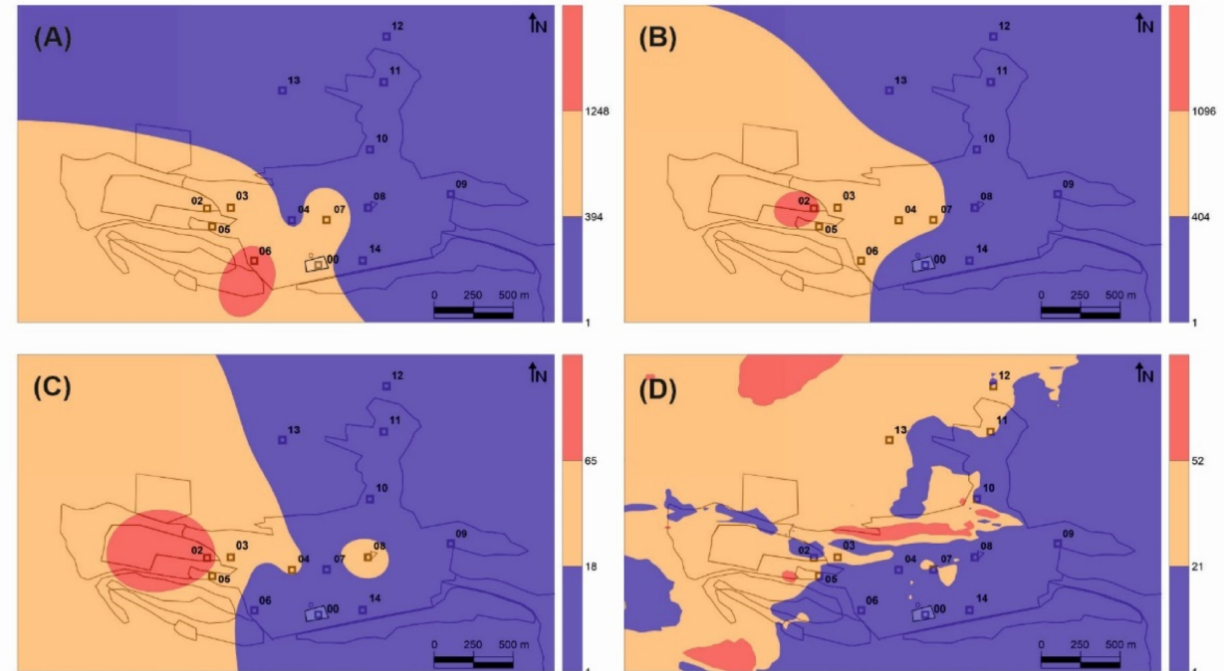
Figure 2. Distribution maps of THg content in bark ( A ) and leaves ( B ) and TGM in Almad é n based on study sites ( C ) and on portable measurements using 6917 sampling locations covering the entire urban area ( D ). THg contents are expressed in ng g − 1 , while TGM levels are expressed in ng m − 3 .